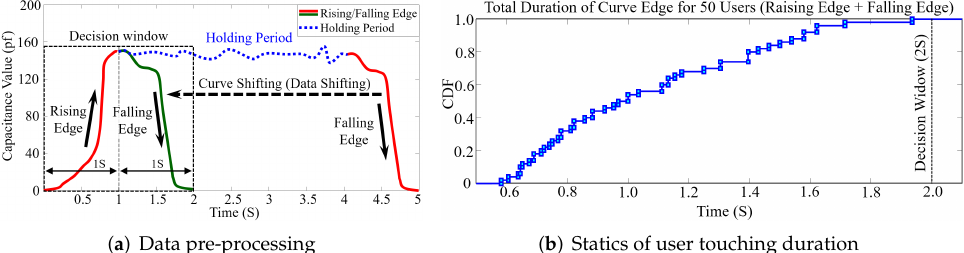
Figure 3. We preprocess the data to eliminate the impact of different touch operations based on an appropriate time window according to user habits. We extract the rising and falling part of the sensed data and remove the holding period to avoid the influences from different touch operations ( a ).